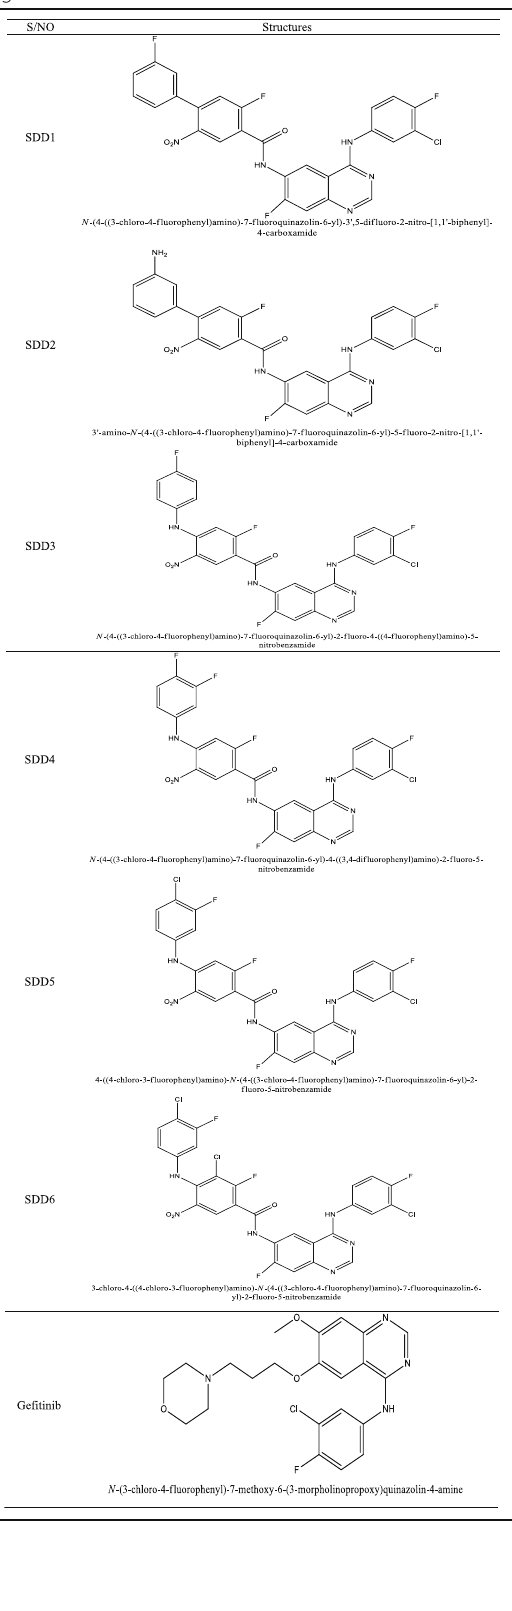
Table 1 The interpretations and mean effect (individual Table 2 The structures of six newly designed EGFR inhibitors and